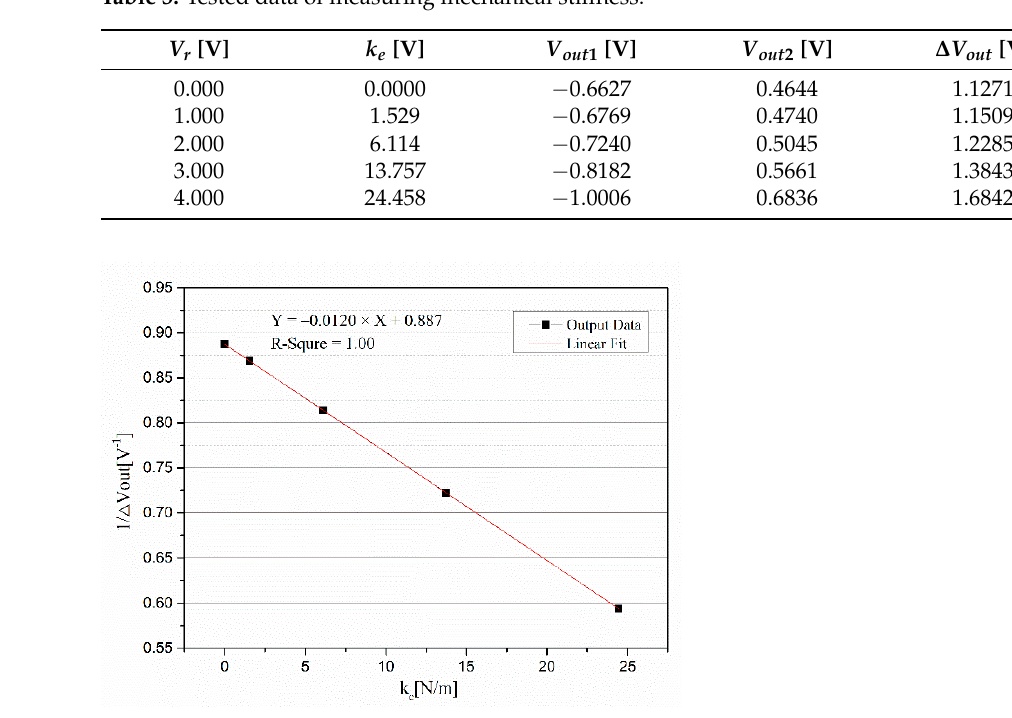
Table 3. Tested data of measuring mechanical stiffness.